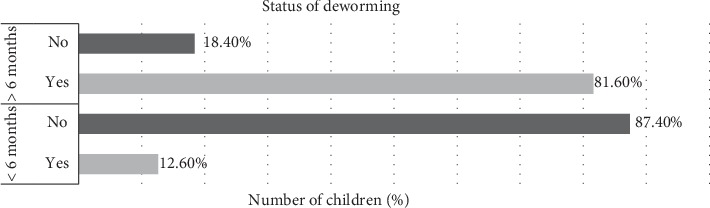
Children dewormed more than 6 months prior to the study. More than 80% of children had been dewormed more than 6 months before the start of this study.